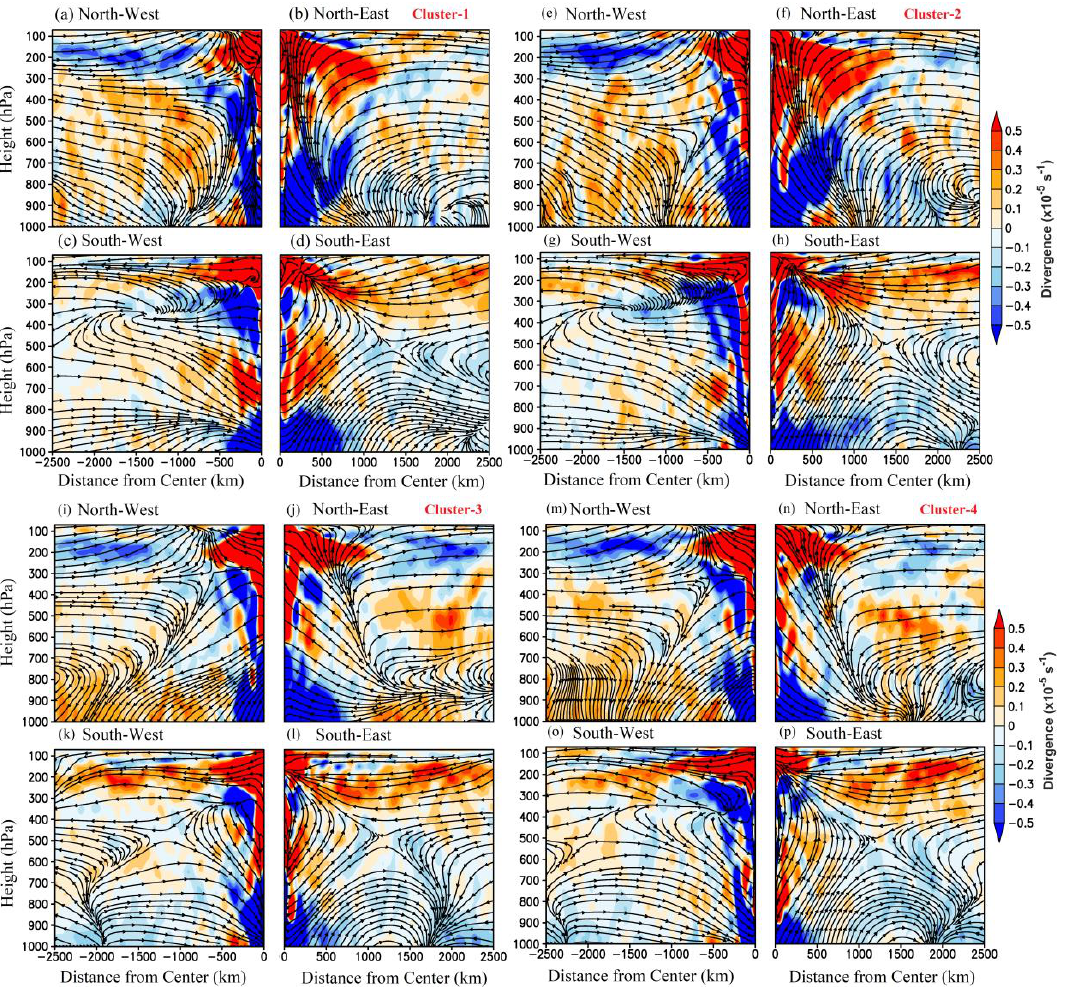
Figure 5. Radial-height cross-section of azimuthally averaged divergence (shaded, ×10 −5 s −1 ) and wind fields (streamlines) shown in each quadrant of the north-west (NW), north-east (NE), south-west (SW), and south-east (SE) from the vortex centre using ERA5 data for Cluster-1 ( a – d ), Cluster-2 ( e – h ), Cluster-3 ( i – l ), and Cluster-4 ( m – p ).